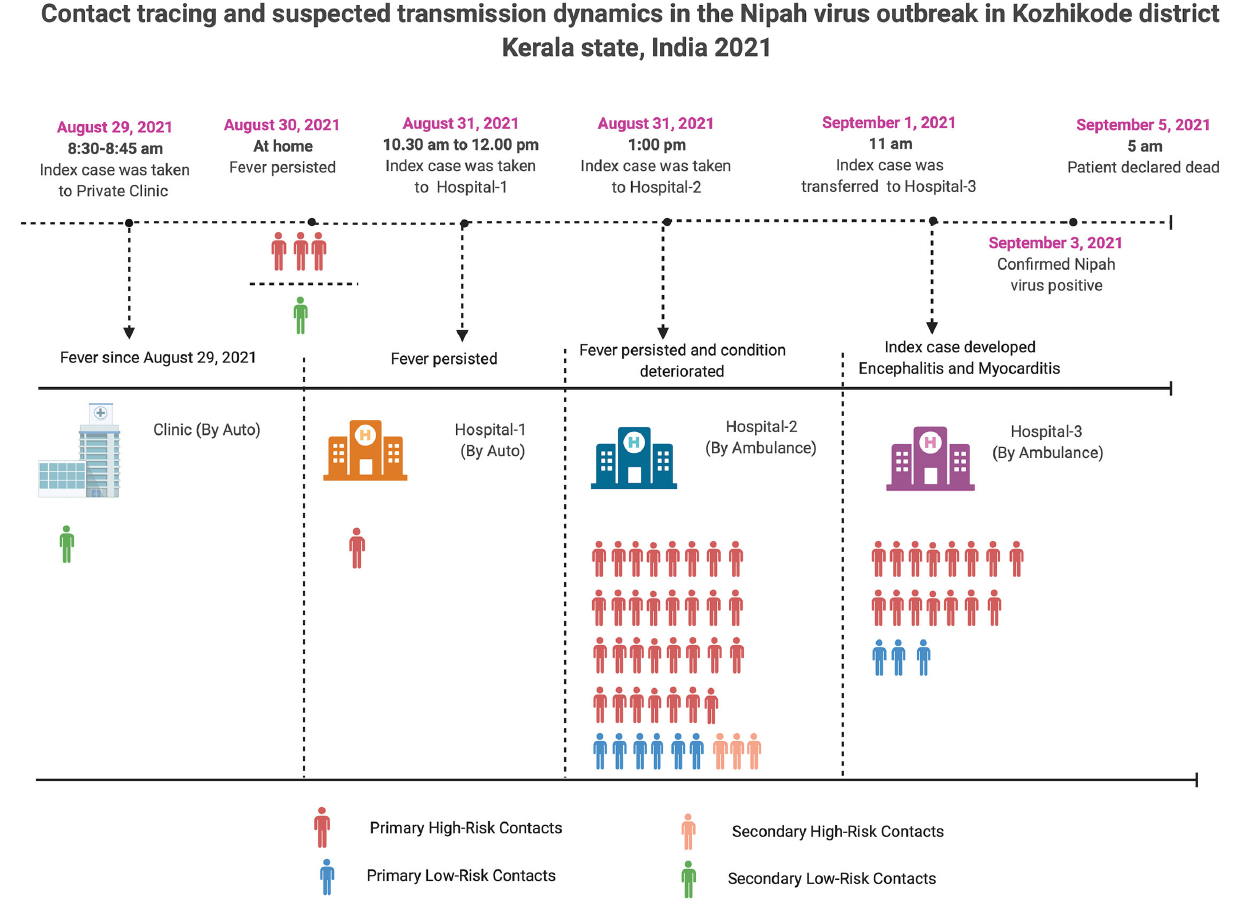
FIGURE 2 | Contact tracing and probable transmission dynamics in the Nipah virus outbreak in Kozhikode district, Kerala state, India, 2021.